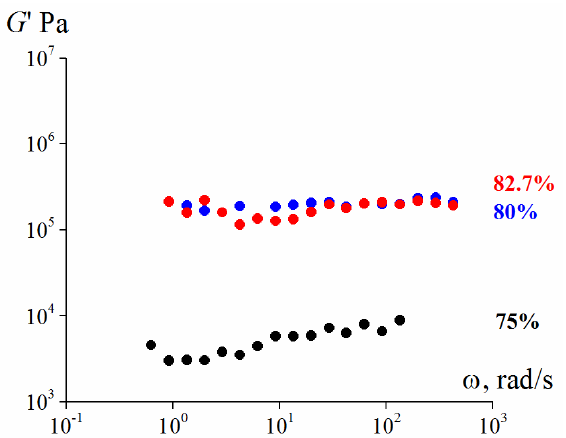
Figure 9. Frequency dependences (at γ = 0.001) of the storage modulus for suspensions with 25% content of smaller particles and λ = 9.4.